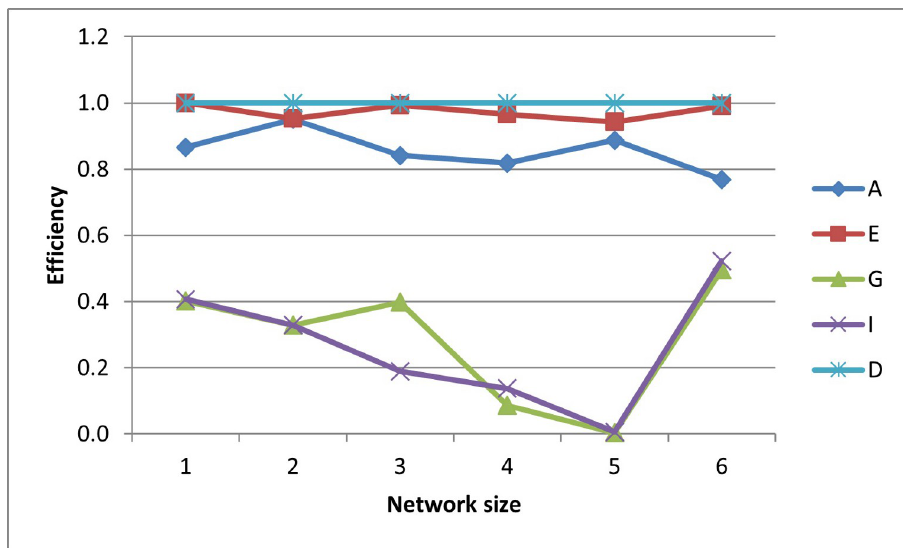
Fig 7. D-efficiencies of various optimal designs for the first case